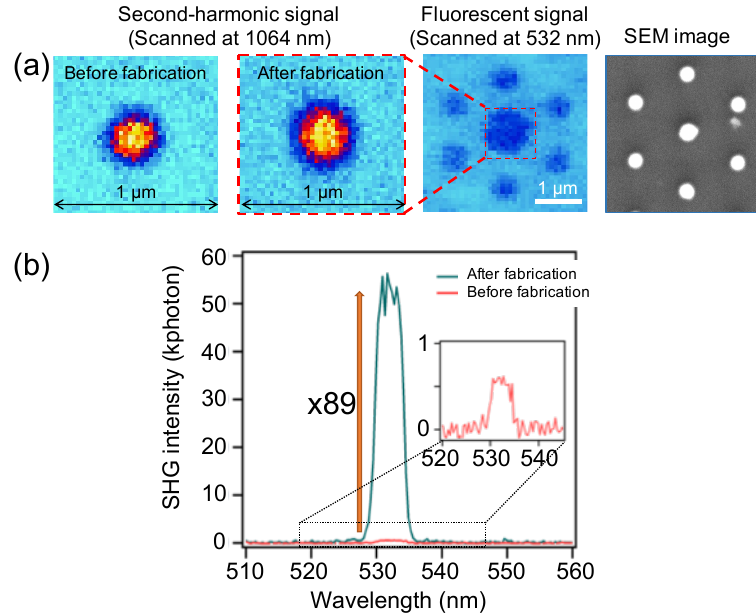
Figure 7. ( a ) SHG images of a KTP NP obtained before and after fabrication, and a fluorescence image of the fabricated structure. In the right: SEM of corresponding fabricated structure. ( b ) Comparison of the SHG spectra intensities of the same KTP NP showing an enhancement factor of about 90; Inset: zoom-in of the SHG spectrum before fabrication.